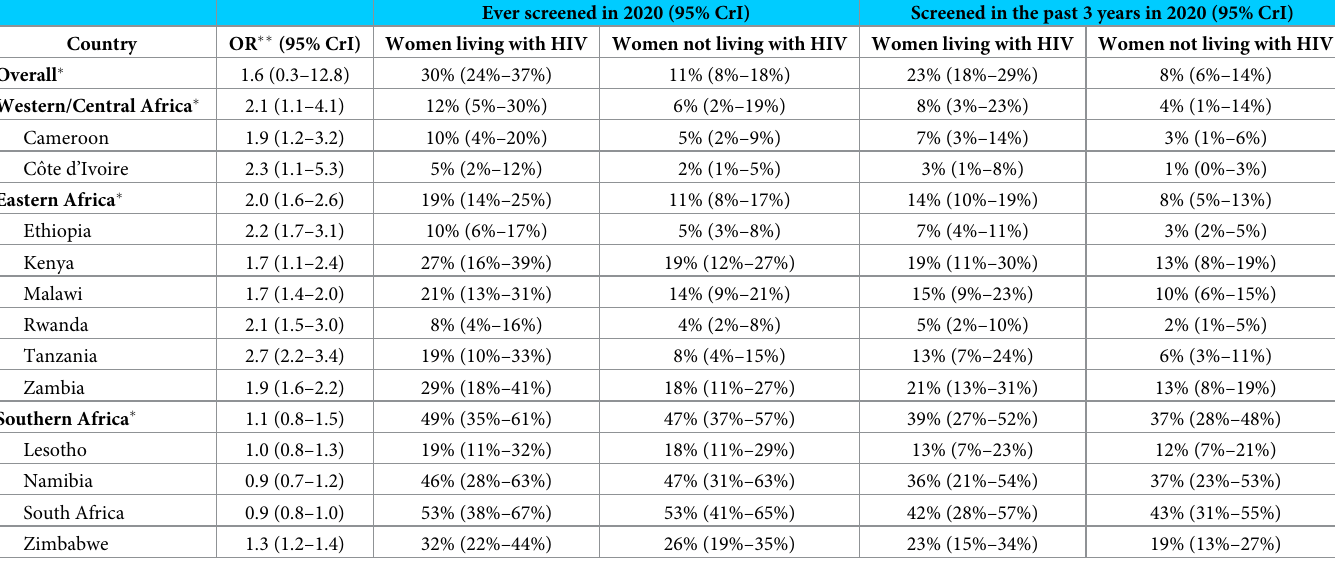
Table 2. Country-level odds ratios of the impact of HIV serostatus on CC screening and regional and country-level estimates of lifetime and past 3-year CC screen- ing among women aged 25–49 living with and without HIV in